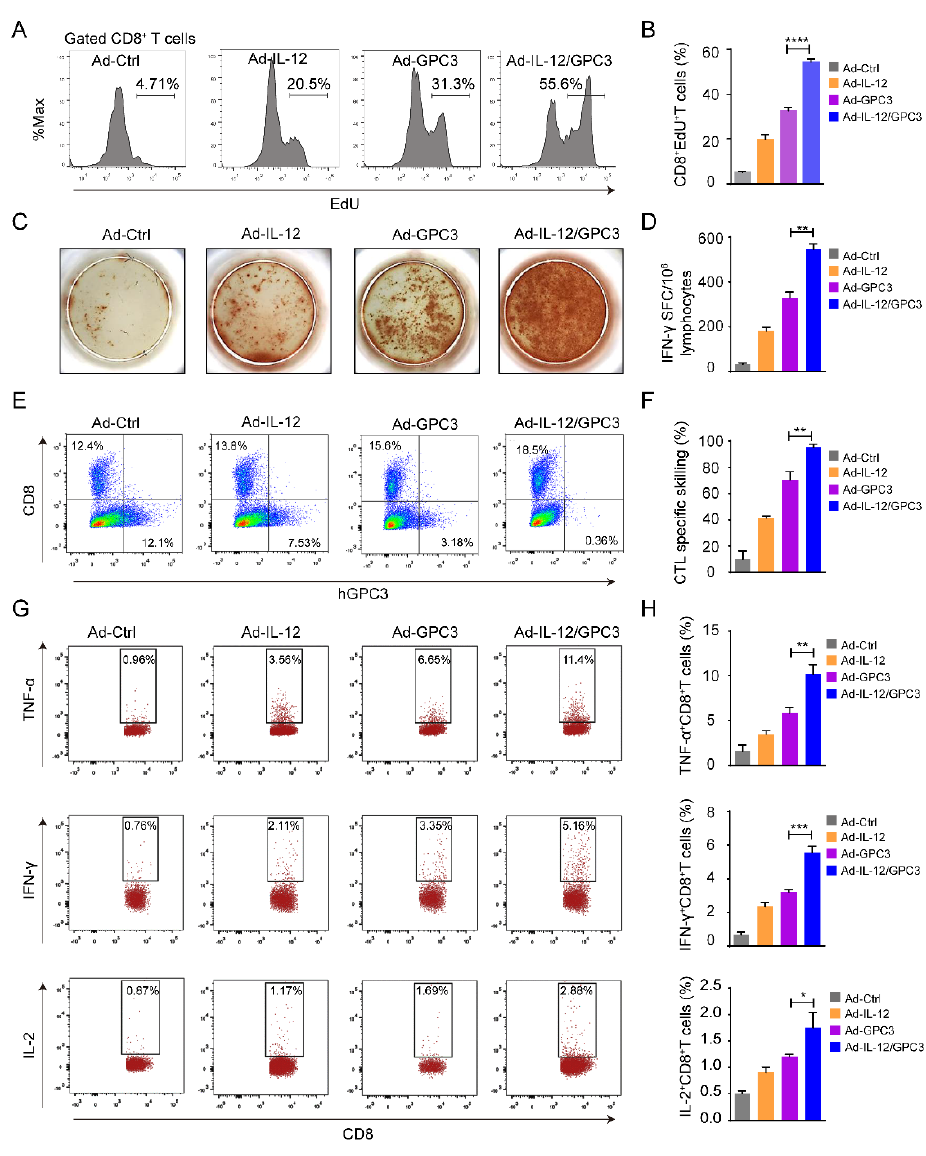
Figure 4. Antigen-specific CTL responses elicited by Ad-IL-12/GPC3 vaccine . ( A ) Splenocytes of immunized mice were isolated and then stimulated with hGPC3 protein. EdU incorporation assay was performed to evaluate cell proliferation ability for every group; ( B ) quantification of EdU + subpopulations in CD8 + T cells; ( C , D ) antigen-specific IFN- γ -secreting T lymphocyte cells were quantified by ELISPOT assay. ( E , F ) CTL activity was conducted to assess the killing ability of splenocytes of immunized mice by FACS. ( G,H ) The splenocytes were analyzed by flow cytometry to evaluate the proportion of TNF- α + CD8 + , IL-2 + CD8 + , and IFN- γ + CD8 + T cells. Results from one representative experiment are shown for each group of mice. Data are from one representative experiment of three performed and presented as the mean ± SD. The different significance was set at * p < 0.05, ** p < 0.01, *** p < 0.001 and **** p < 0.0001.